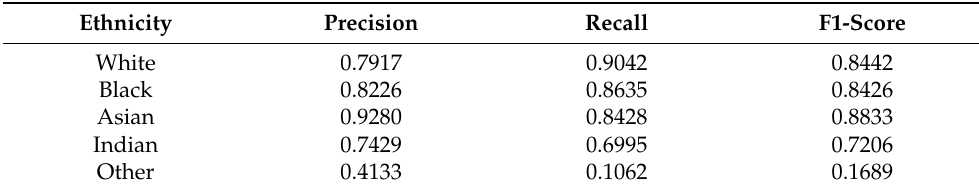
Table 15. Results for the UTKFace filtered testing with plotted landmarks. Ethnicity Precision Recall